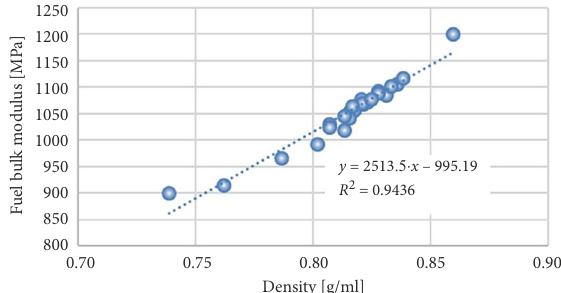
Figure 7. Relationship between density and bulk